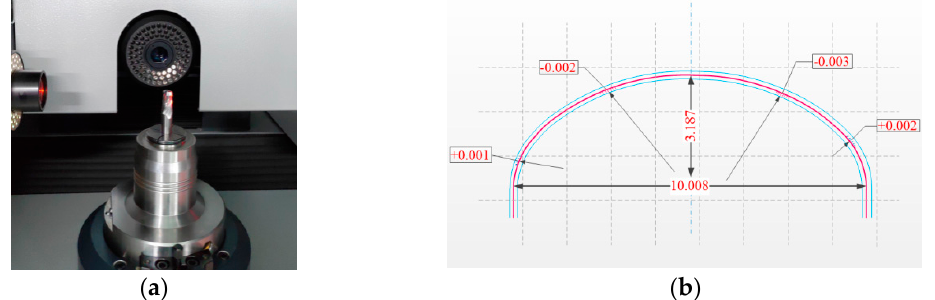
Figure 10. Profile accuracy detection of a revolving cycloid milling cutter: ( a ) Test equipment; ( b ) test results.